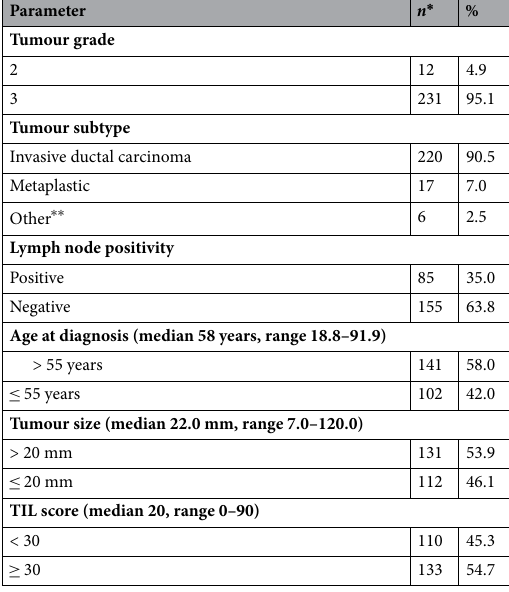
Table 1. Characteristics of the clinicopathological parameters of the TNBC dataset. * n is the number of patients in the full dataset (statistical analysis is carried out in 3 stages and the number of patients for each stage is indicated in the relevant table). ** Other includes invasive micropapillary, lobular and apocrine